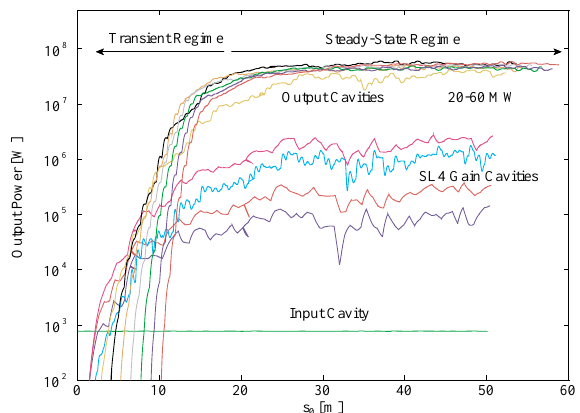
later cavities decreases. In fact, it may even be desirable